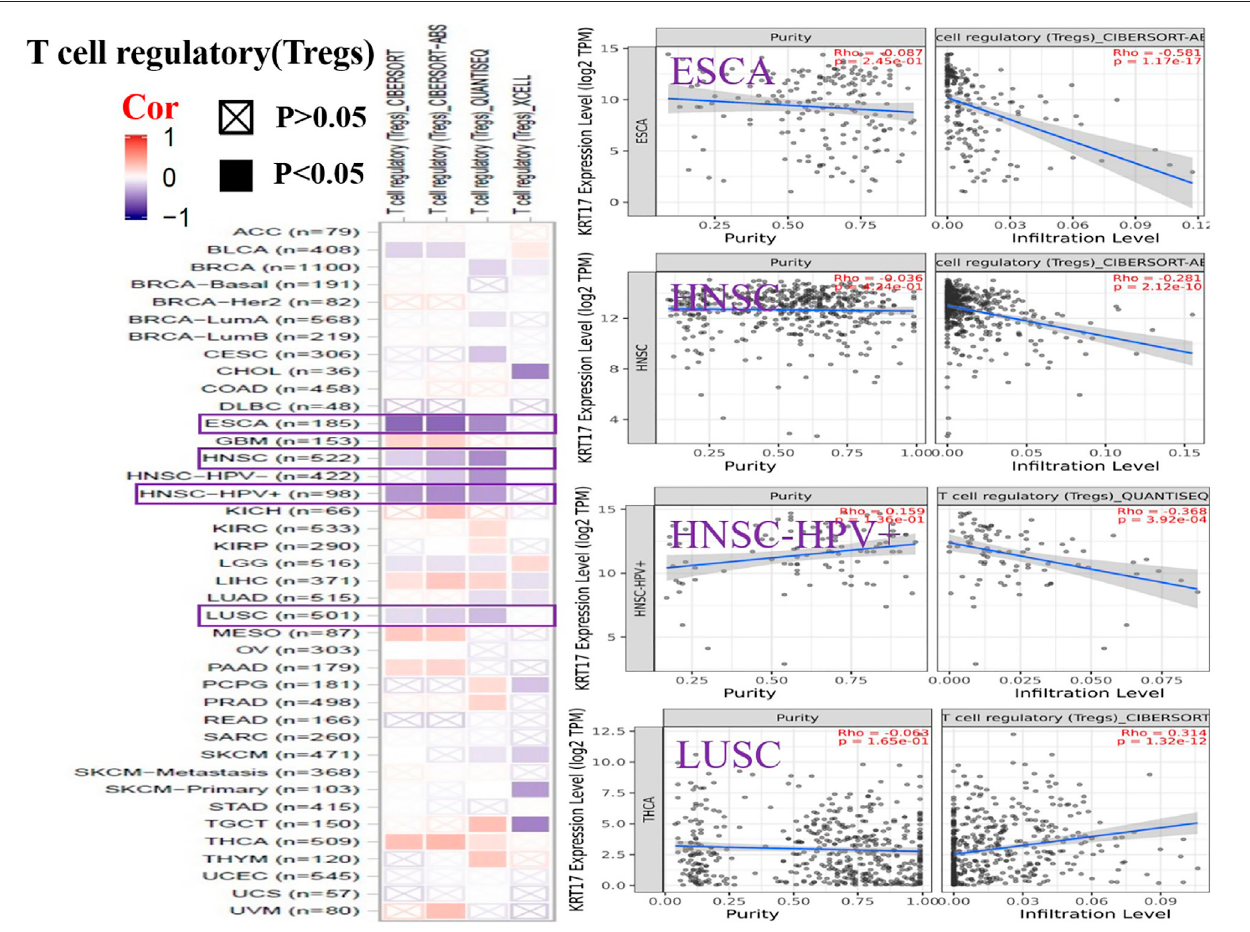
FIGURE 9 | Correlation between KRT17 expression and immune in fi ltration of Tregs cells. In ESCA, HNSC, and HNSC-HPV+ and LUSC, KRT17 expression was negatively correlated with Treg expression (TCGA